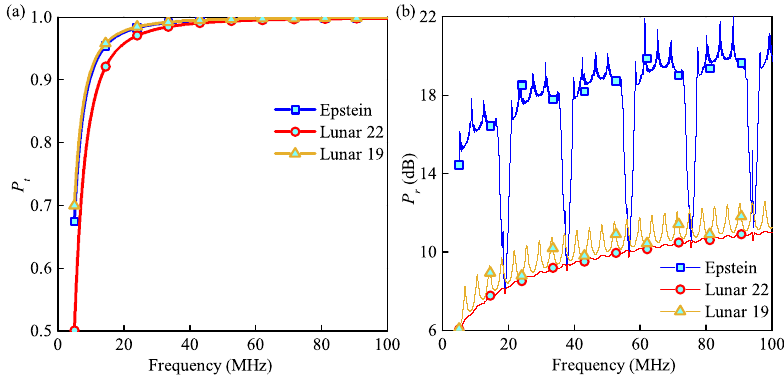
Figure 3. ( a ) P t and ( b ) P r versus wave frequency under three ionosphere